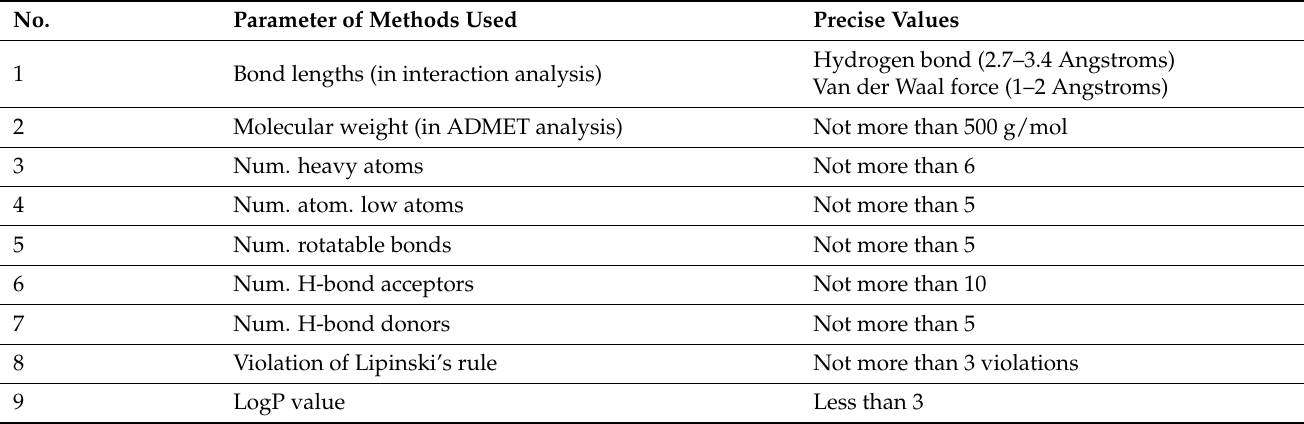
Table 5. Description of parameters used in throughput methodology and their precise values .